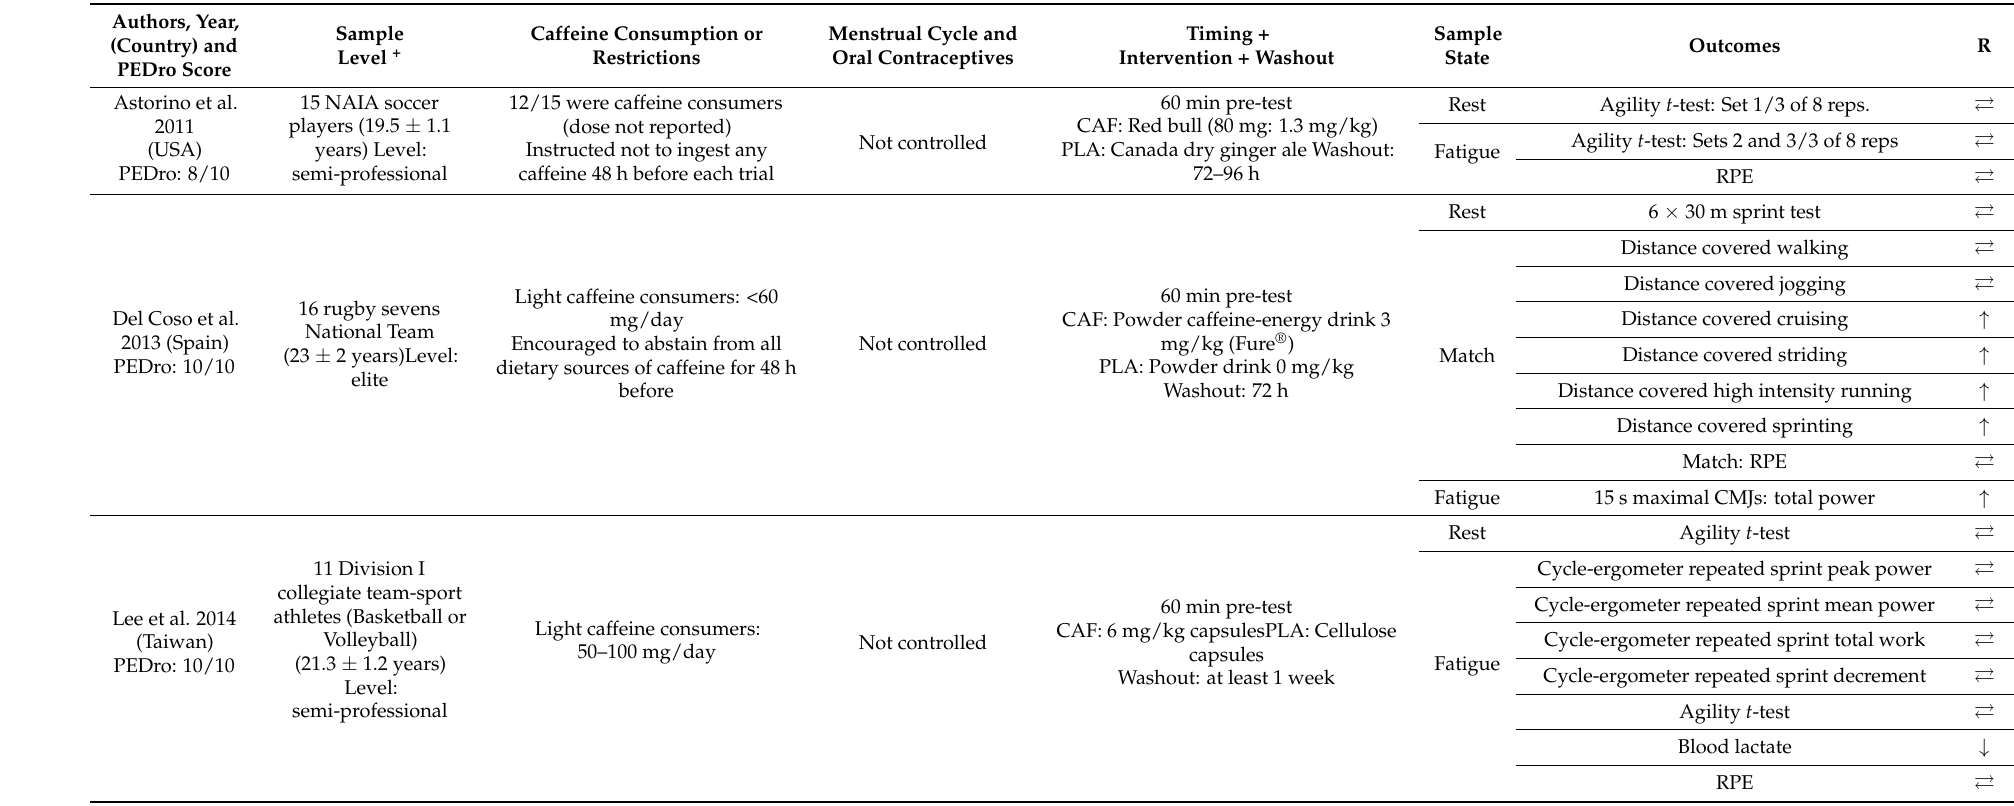
Table 1. Characteristics of studies included in the systematic